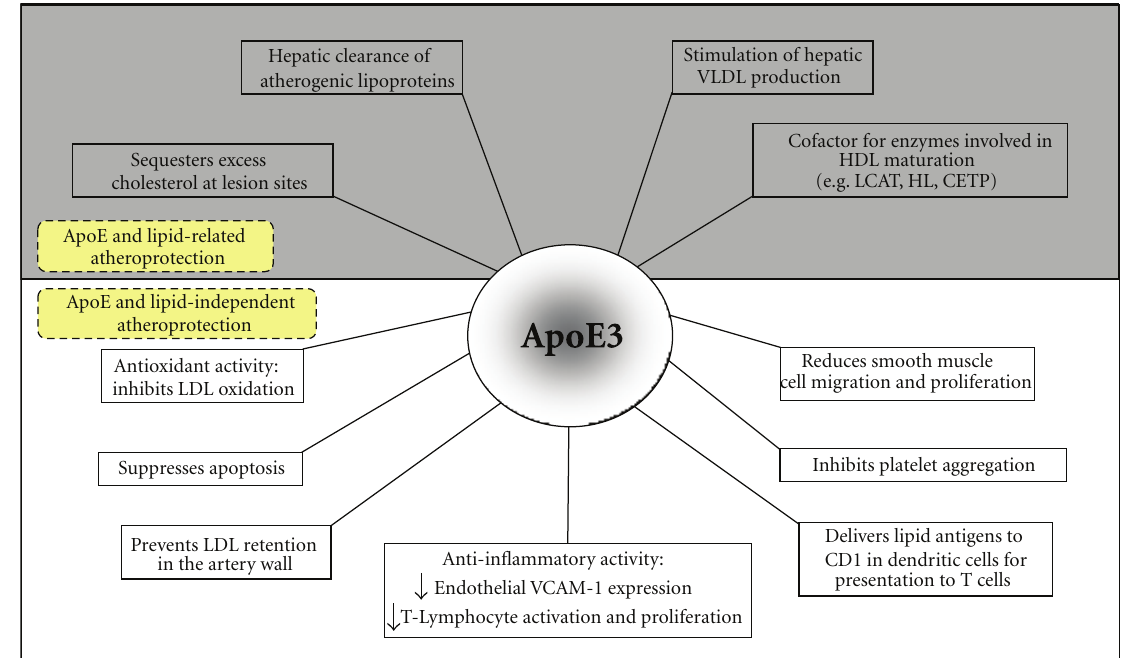
Figure 2: Proposed atheroprotective functions of ApoE3. The antiatherogenic properties of ApoE3 are divided into those related to its role in lipid metabolism (shaded area) and those independent (unshaded